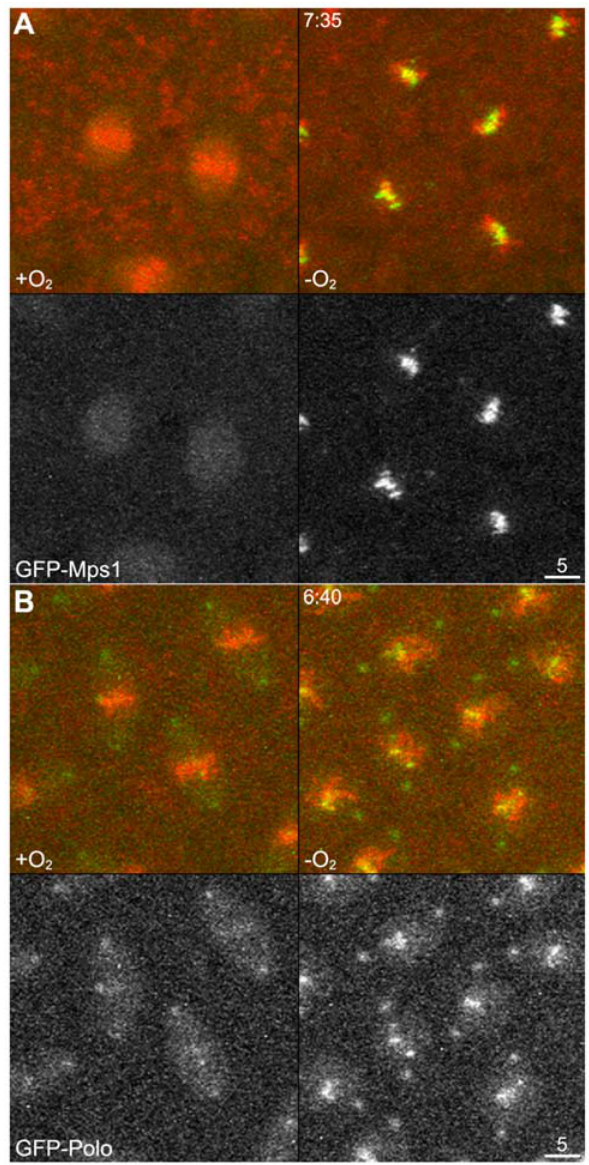
Figure 5. Hypoxia changes localization of Polo during mitosis. Metaphase chromosomes in embryos expressing either GFP-Mps1 or GFP-Polo (green) and a red fluorescent histone (His2AvD-tDimer, red) are presented. Each is shown at two successive cycles of mitosis, with the central two nuclei in the first cycle (left) dividing vertically to give rise to the central four nuclei in the next cycle (right). The left cycle is normoxic, and embryos underwent hypoxic arrest in metaphase of the next cell cycle after the flow of CO 2 was turned on. Both merged and GFP-only signals are shown. Timestamps are the time elapsed since the CO 2 was turned on. Both embryos resumed mitotic cycling after a return to normoxia (GFP-Mps1 data not shown; GFP-Polo in Movie S3). 5A: An embryo expressing GFP-Mps1 shows diffuse Mps1 signal around the chromosomes during normoxia (left), and kinetochore localization during hypoxia (right). This demonstrates that we can recreate the published localization of Mps1 in response to hypoxia [21] using our apparatus. 5B: The same embryo as shown in Movie S3, at metaphase of successive cell cycles, showing that GFP-Polo localizes to centrosomes, spindle and kinetochores during normoxia, while during hypoxia it is enriched only at centrosomes and